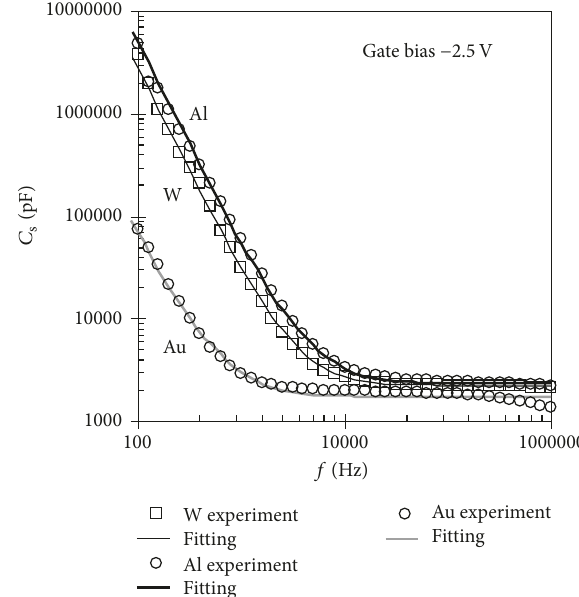
Figure 5: Comparison of experimental and theoretical results for effective series